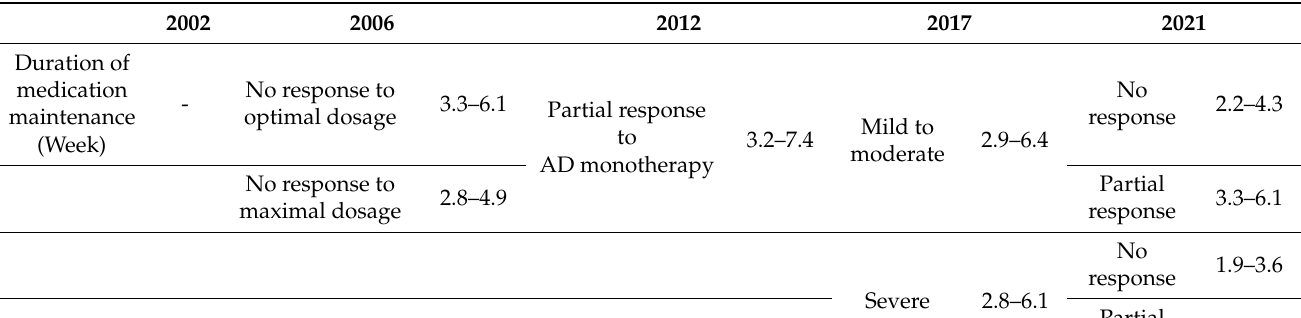
Table 1. Changes in the adjustment period of treatment strategies in